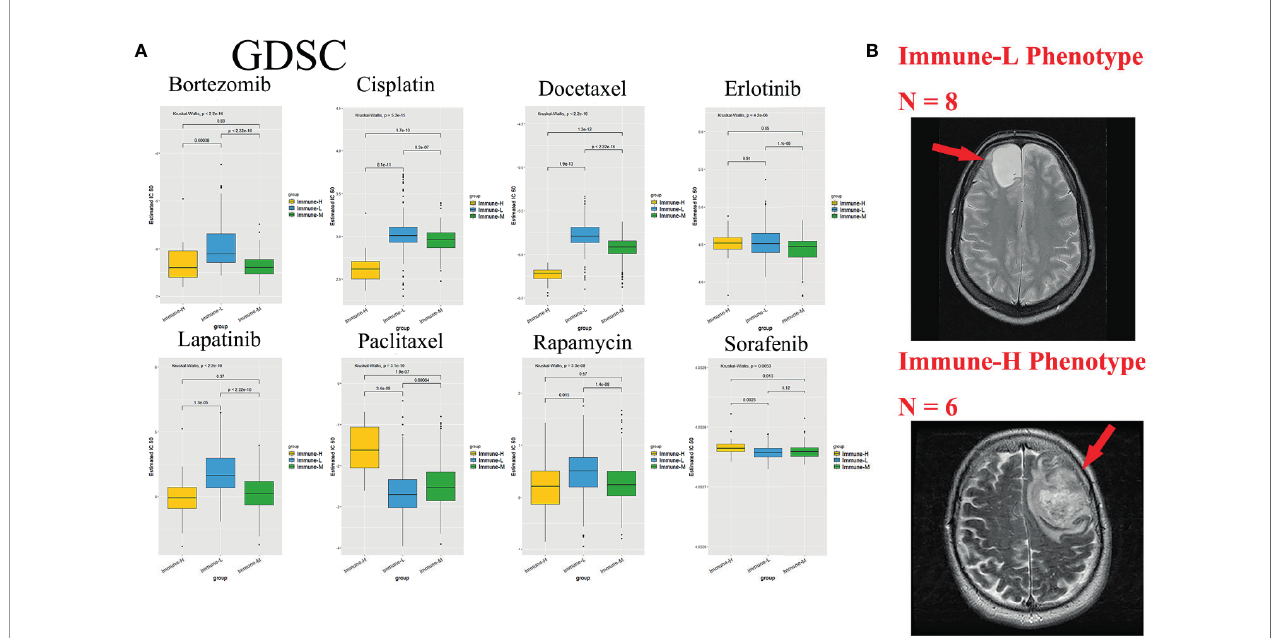
FIGURE 10 | Role of phenotype in predicting anti-tumor drugs response and peri-tumoral edema. (A) The immune-L phenotype was more sensitive to bortezomib (P < 2.2e-16), cisplatin (P = 5.3e-15), docetaxel (P < 2.2e-16), lapatinib (P < 2.2e-16), rapamycin (P = 3.3e-8); the immune-H phenotype was more sensitive to paclitaxel (P = 3.1e-10) and sorafenib (P = 0.0053). (B) Representative images of the differences in the extent of peri-tumoral edema in TCGA cohort patients. Immune-H phenotype signi fi cantly possessed more-severe edema than immune-L.